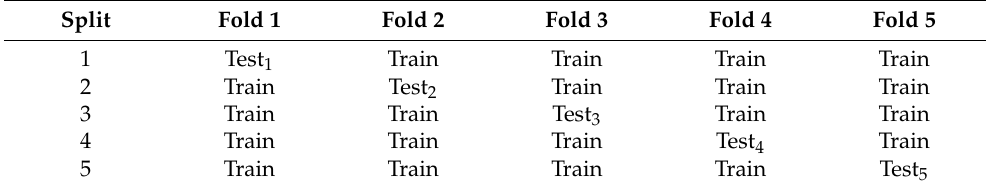
Table 1. Representation of the data set by train and test folds in tabular form [26]. Split Fold